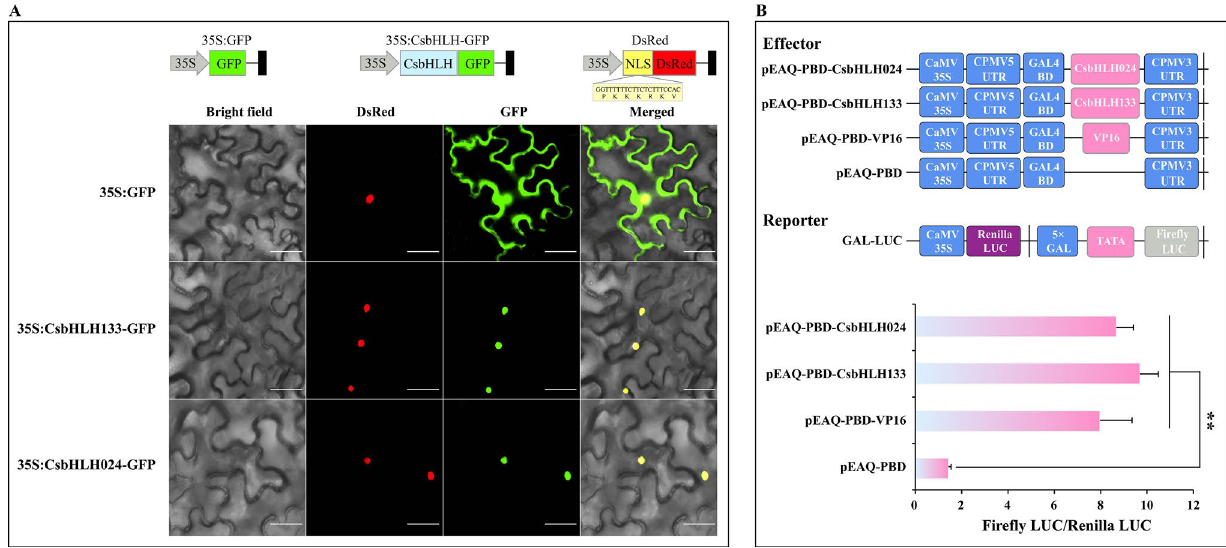
Figure 6. Transcriptional activity of CsbHLH133 and CsbHLH024. ( A ) The subcellular location of CsbHLH133 and CsbHLH024 in Nicotiana benthamiana . Scale bars = 50 μm. ( B ) The transcriptional activation of CsbHLH133 and CsbHLH024 in planta . The data are presented as the means ± SDs (n = 7). Empty vector (PBD) and pBD-VP16 were used as negative and positive controls, respectively. Significant differences were determined using Student’s t-test by comparison to the negative control (**, P < In addition, the expression of CsTTG1 maintained good agreement with that of CsbHLH024 and CsbHLH133 (Fig. 7C). These results suggested that CsbHLH024 and CsbHLH133 might regulate trichome formation by interacting with multiple TFs.